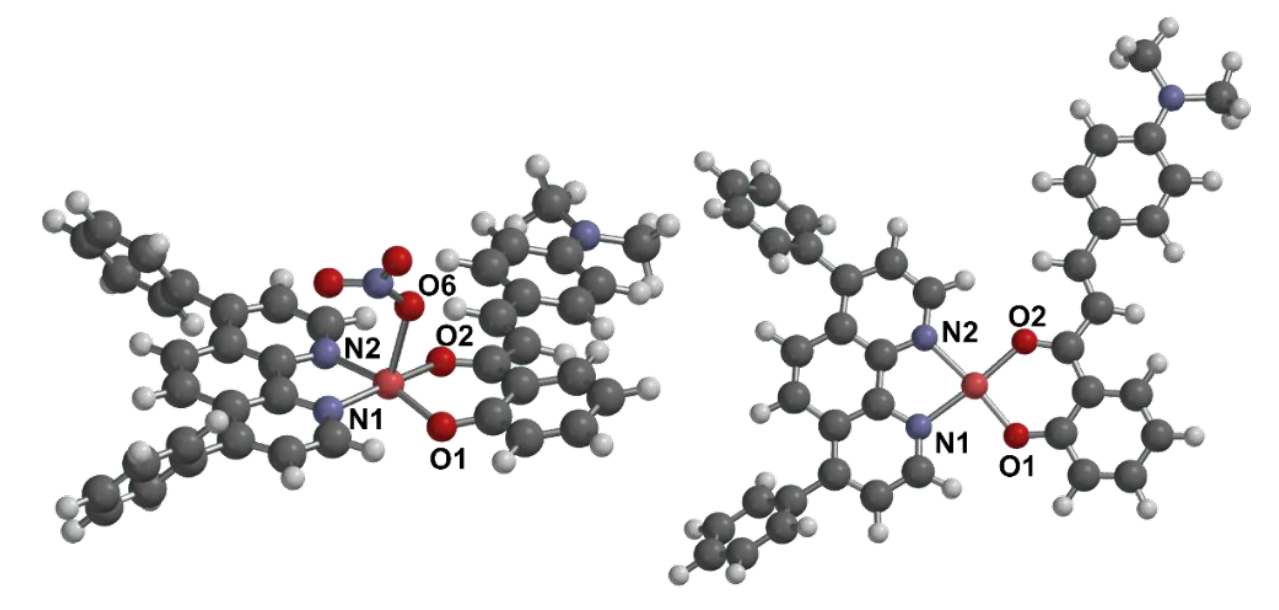
Figure 1. The geometries of the [Cu(bphen)(L)(NO 3 )] ( 2 ) ( left ) and [Cu(bphen)(L)] + ( right ) species optimized in a water solvation model at the (cid:36) B97X-D/def2-tzvp level of theory. The color coding of the atoms is as follows: hydrogen atom − light gray, carbon atom − dark gray, nitrogen atom − blue, oxygen atom − red, copper atom − orange. Table 2. Selected interatomic parameters (in Å and ◦ ) in the vicinity of the copper(II) atom for both forms of complex ( 2 ) as determined using DFT calculations at the ω B97X-D/def2-tzvp level of theory in the vacuum and water solvation models, and their comparison with the X-ray struc- turally determined values for [Cu(phen)(L)(NO 3 )] and [Cu(phen)(chal1)(NO 3 )], where Hchal1 = 2 (cid:48) -hydroxychalcone {(E)-1-(2 (cid:48) -hydroxyphenyl)-3-phenylprop-2-en-1-one}.